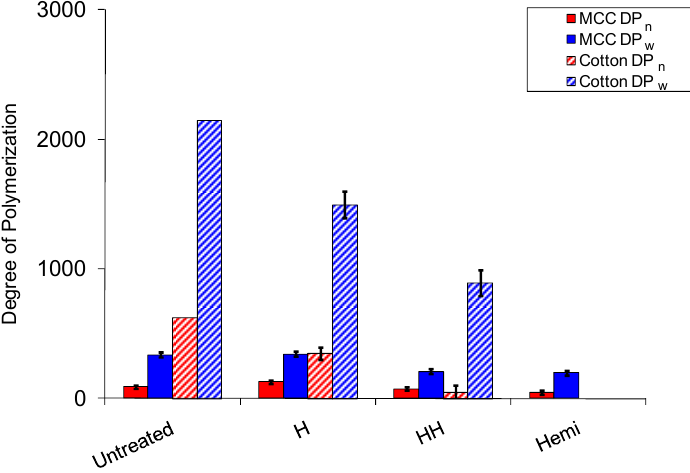
Figure 5. Degree of polymerization of microcrystalline cellulose and cellulose from cotton swaps after various treatments used to isolate cellulose from whole biomass samples. The error bars represent the standard deviations. Hemi = hemicellulose removal by acid hydrolysis, H = holocellulose pulped, HH = holocellulose pulped and hemicellulose removal by acid